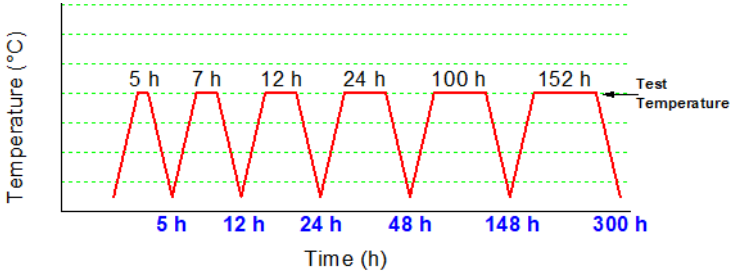
Figure 1. High temperature oxidation test cycle .